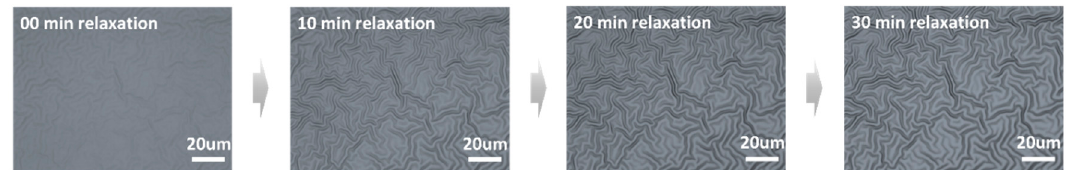
Figure 3. Variation of the surface features of the wrinkles with the relaxation time after the low-pressure plasma treatment. Oxygen gas was used to generate low-pressure plasma. The plasma power and treatment time were 30 W and 30 s, respectively. Gas flow rate was 24 sccm.